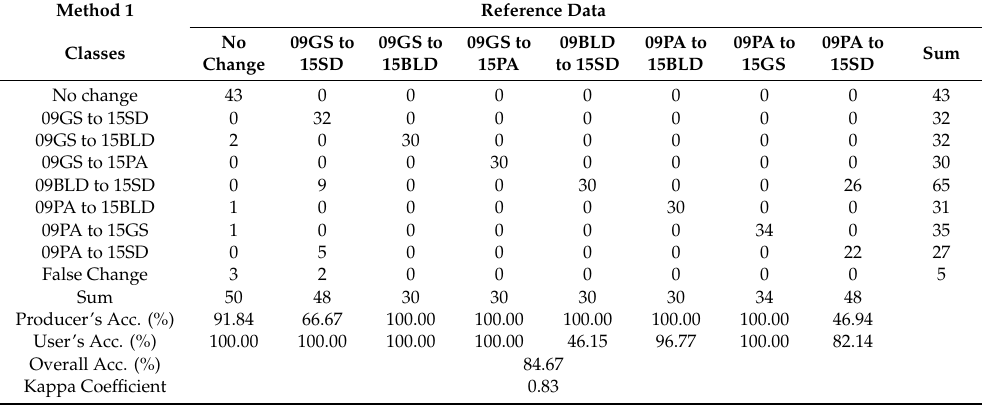
Table 10. The classification accuracies of changes in Method 1.